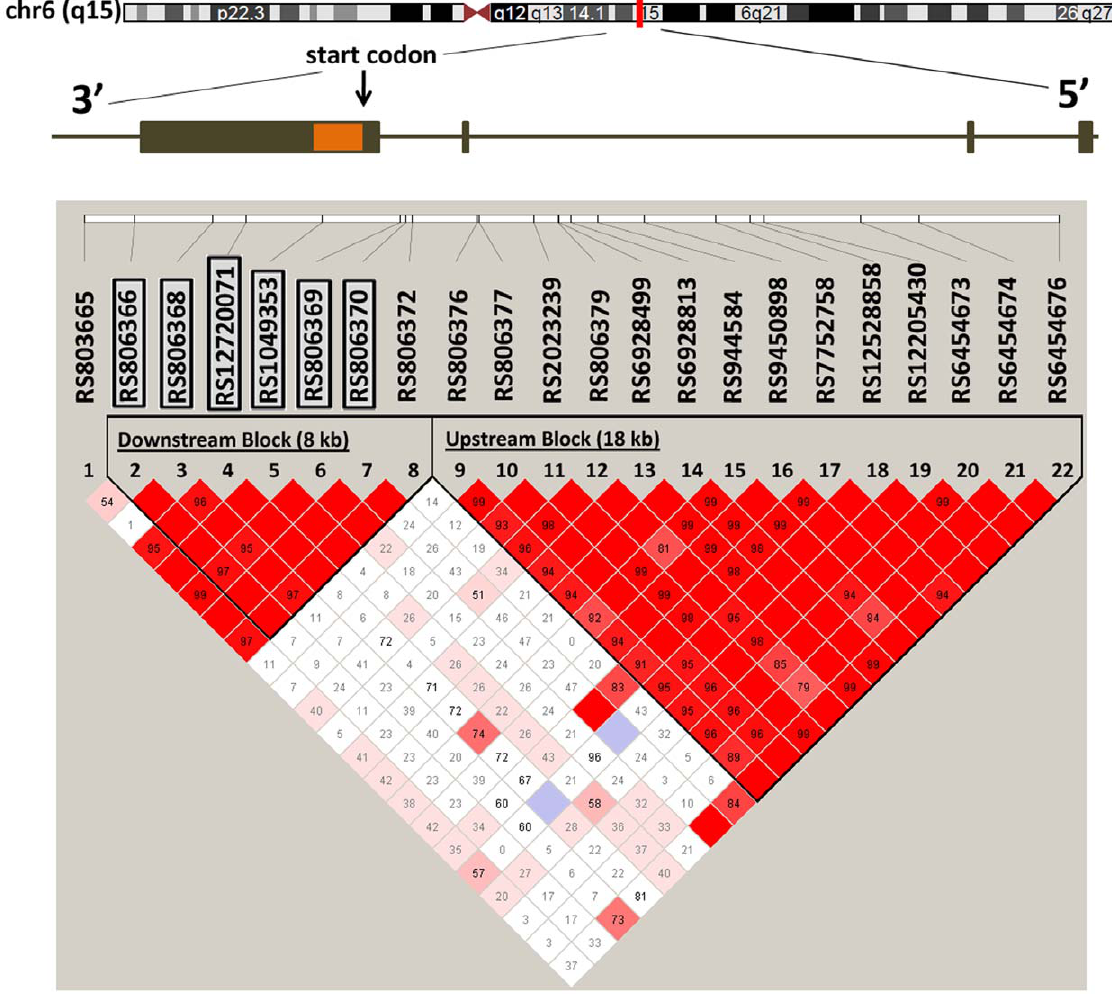
Figure 3. Chromosomal location for CNR1, and linkage disequilibrium (LD) structure within the PMRP database. The chromosome position of the CNR1 gene was obtained from the UCSC human genome browser for the entire gene plus 15 kb upstream and 5 kb downstream (http://genome.ucsc.edu/). SNPs within the identified region were quantified within our study cohort (n=645) and entered into Haploview for an assessment of LD and tagSNP assignment. Applying the confidence interval method implemented in Haploview version 4.0, we observed two haplotype blocks covering the entire region of interest. CNR1: Cannabinoid receptor 1; LD: Linkage disequilibrium; UCSC: University of California, Santa Cruz.